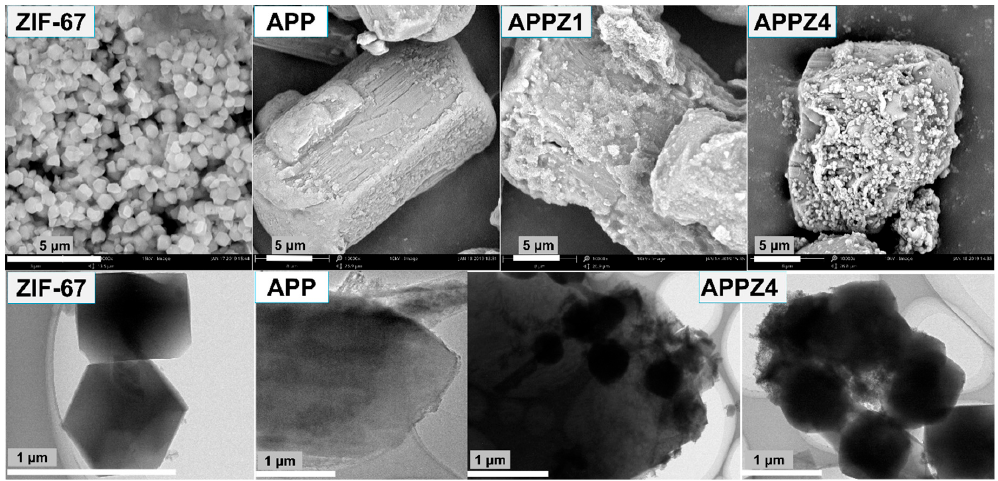
Figure 3. SEM images of the ZIF-67, APP, APPZ1, and APPZ4 (first line); TEM images of ZIF-67, APP, and APPZ4 (second line).